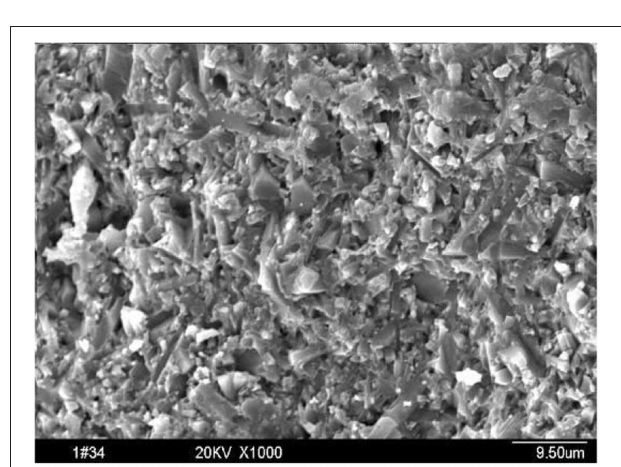
FIGURE 2 | SEM micrograph of fracture surface of Si 3 N 4